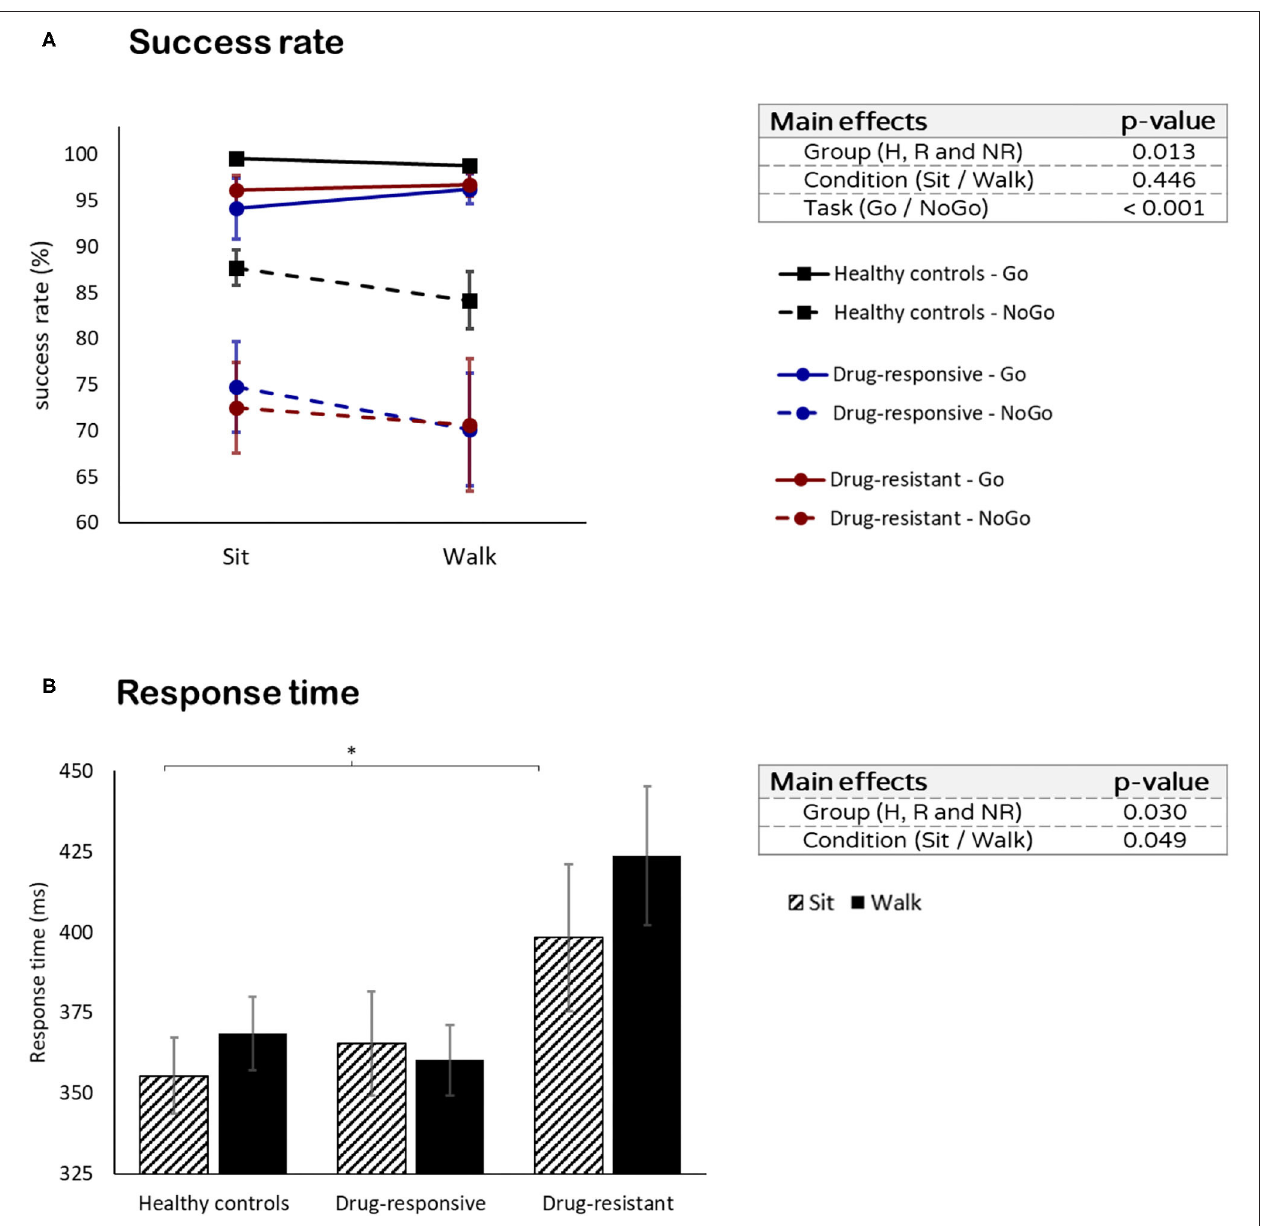
FIGURE 2 | Visual Go/NoGo task performance: (A) success rate in the Go (solid line) and NoGo (dashed line) tasks and (B) the response times while sitting and while walking. * p ≤ 0.05.